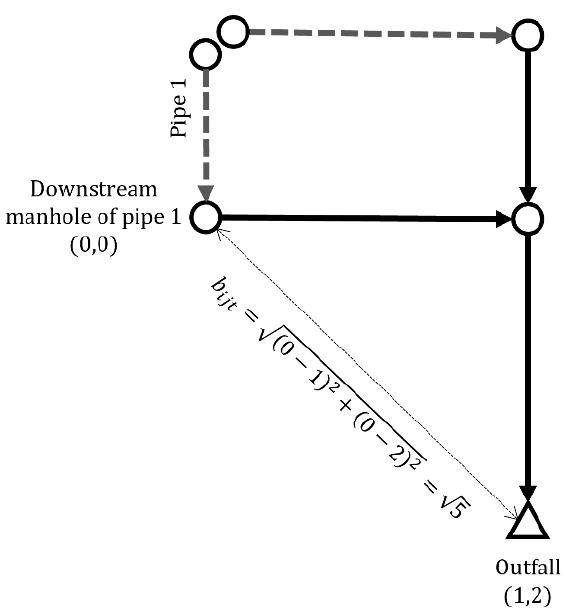
Figure 4. Example of the calculation of 𝑏 𝑖𝑗𝑡 with Criterion 3.